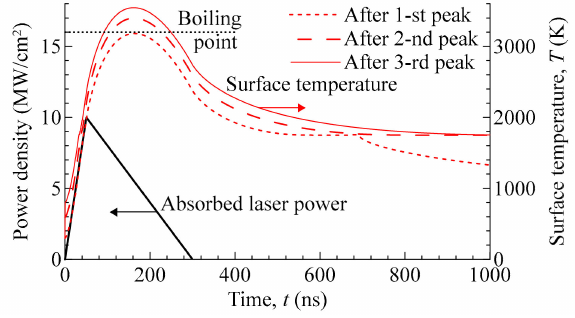
Figure 5. Increase of the surface temperature due to heat accumulation in the target at laser processing by the sequence of pulses with I max = 10 MW / cm 2 and the inter-pulse separation 10 µ s.